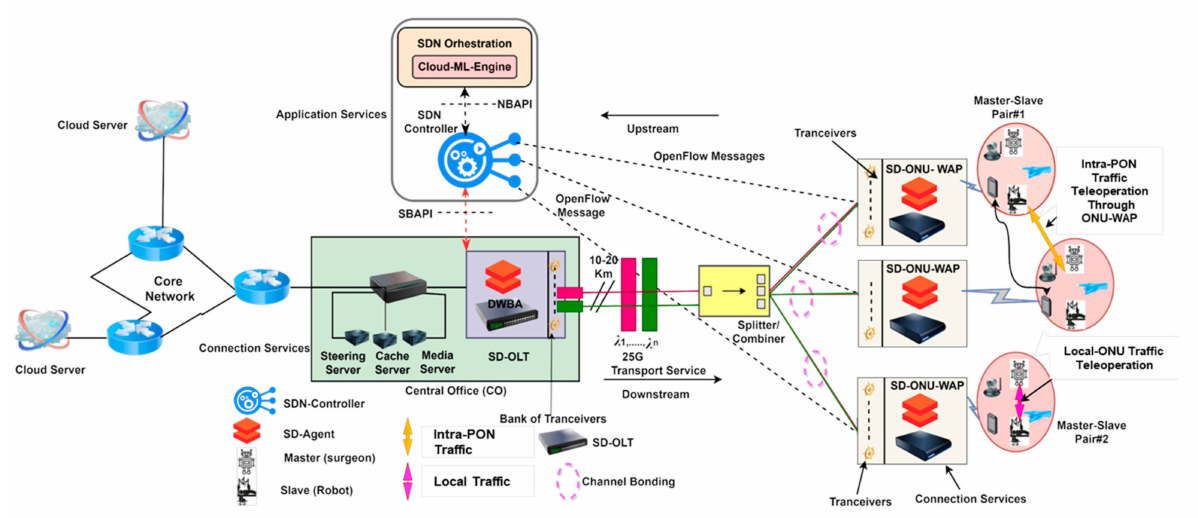
Figure 2. Proposed high–level architecture of cloud–based